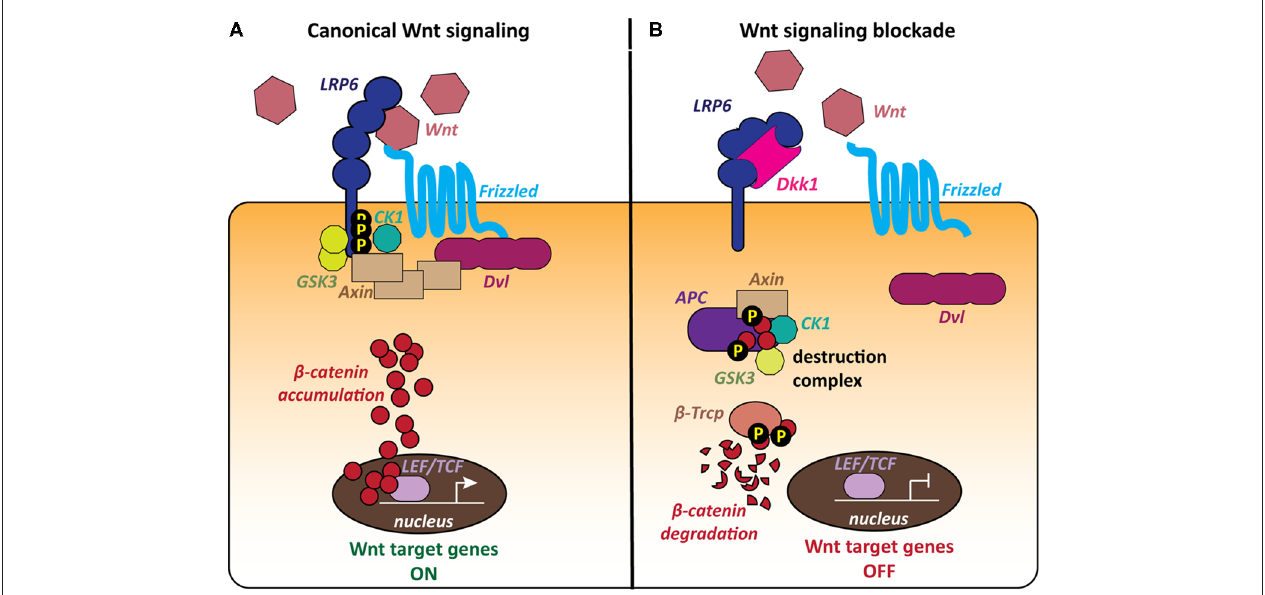
FIGURE 1 | The canonical Wnt pathway and the role of the LRP6 receptor. The LRP6 receptor occupies a unique position within the canonical Wnt pathway as it is involved in both activation and blockade of the cascade. (A) The canonical Wnt cascade is activated by binding of secreted Wnt molecules to the Frizzled (Fz) receptor and LRP6 co-receptor at the cell surface. The formation of this complex leads to the recruitment of the scaffold protein Dishevelled (Dvl) and phosphorylation of the LRP6 C-tail by the kinases GSK3 and CK1. Cytoplasmic β -catenin accumulates and then translocates to the nucleus and activates Wnt target genes. (B) The secreted Wnt antagonist Dickkopf 1 (Dkk1) blocks Wnt signaling by binding to the LRP6 receptor, thereby preventing the formation of the Wnt-Fz-LRP6 complex. The cytoplasmic destruction complex containing Axin, APC, GSK3 and CK1 phosphorylates β -catenin, targeting it for proteasomal degradation. Wnt target genes remain